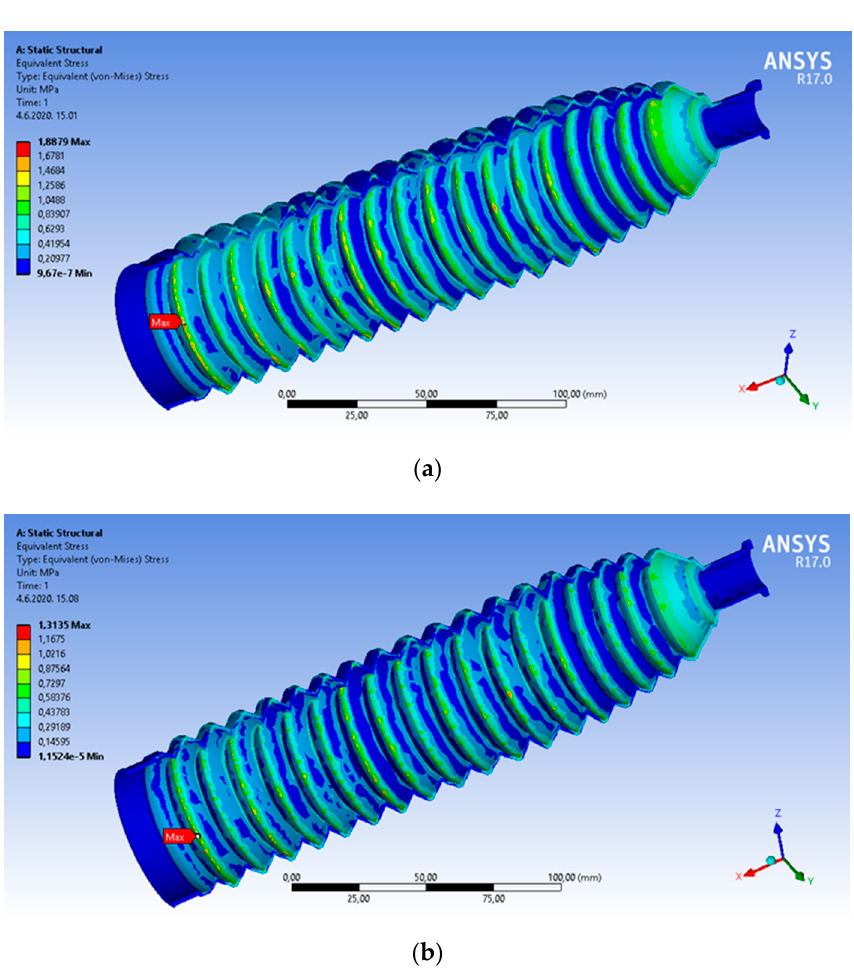
Figure 10. Equivalent von Mises stresses in longitudinal cross-section of a cuff (isometric view) at different temperatures: ( a ) at − 20°C; ( b ) at 20°C.